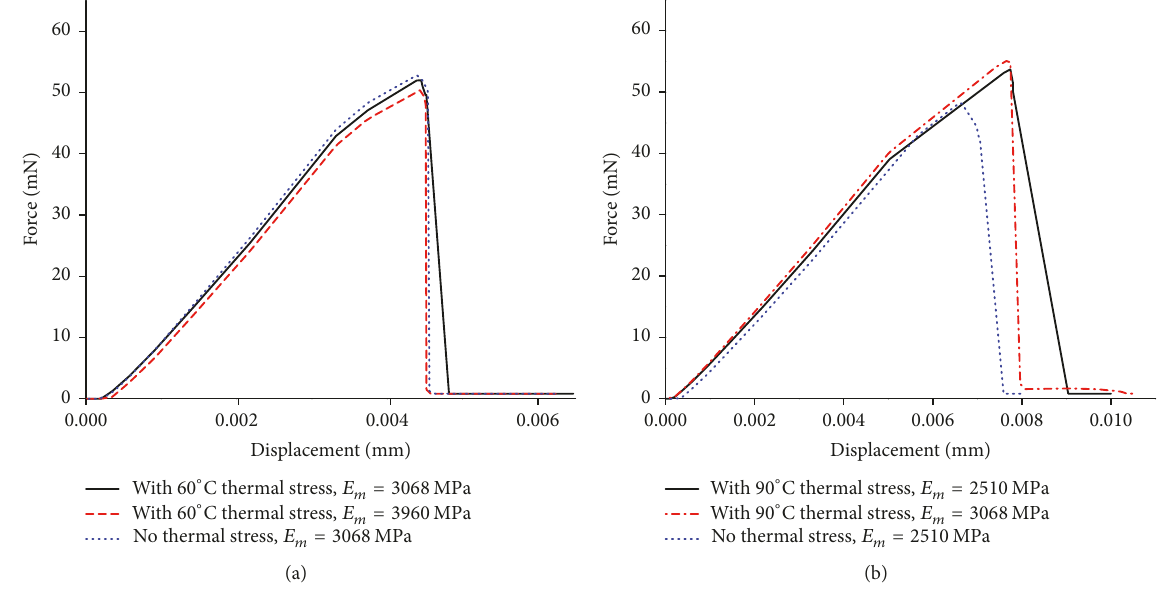
Figure 12: Simulated force-displacement curves for the effect of CLET and EP’s modulus (a) under 60 ∘ C and (b) under 90 ∘ C.